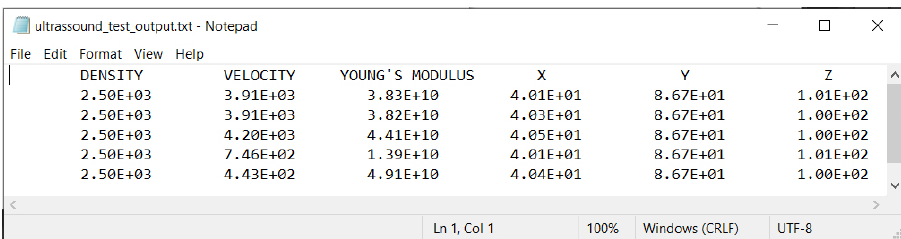
Figure 6. Post-processing data structure from ultrasound tests.